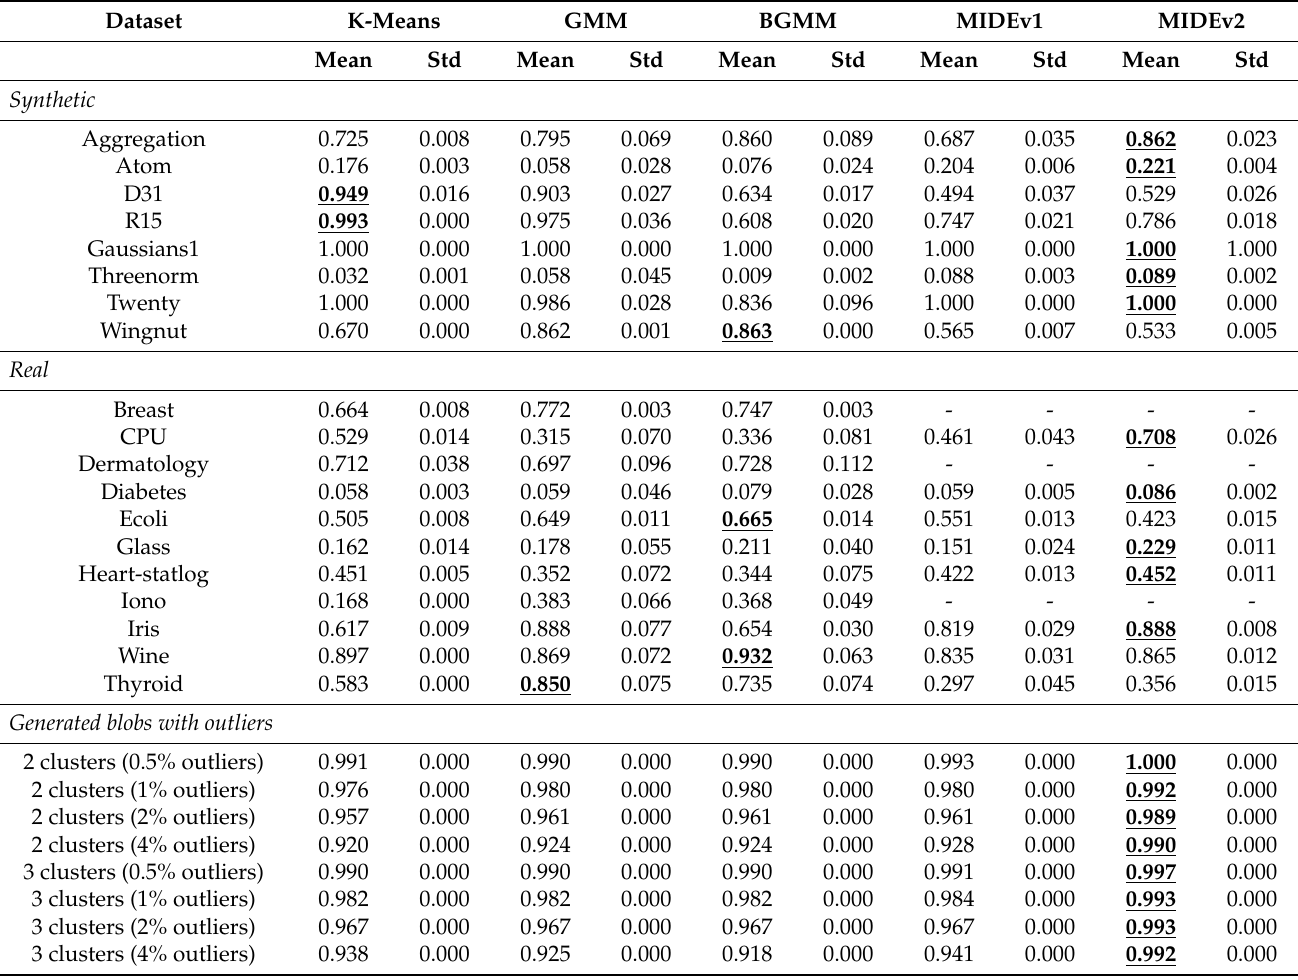
Table A2. Comparative analysis of different models (means and standard deviation) based on the adjusted Rand Index (ARI) for 10,000 runs.